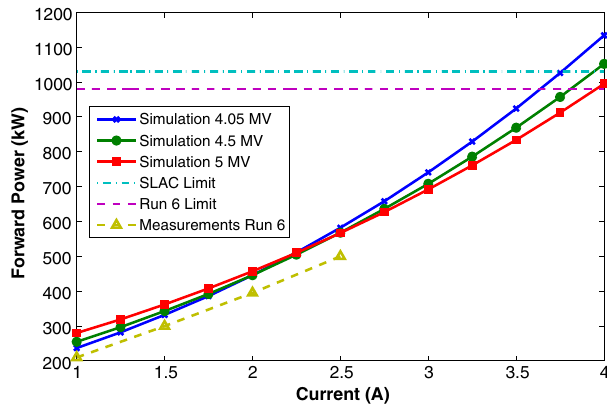
FIG. 7. (Color) LER klystron forward power versus current.